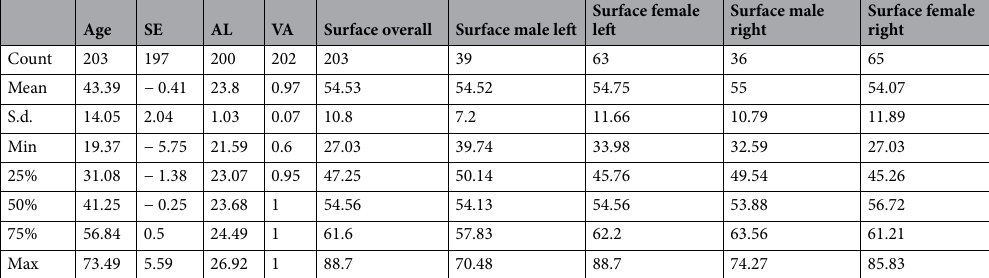
Table 1. Summary statistics of age, spherical equivalent (SE), axial length (AL), visual acuity (VA), and optical coherence tomography angiography (OCTA) retinal vessel surface area measurements. Summary statistics are calculated from 203 eyes (102 left and 101 right). Count indicates the number of eyes for which the respective measurements were available. Mean, s.d., min, 25%, 50%, 75%, and max indicate mean, standard deviation, minimum, 1st quartile, 2nd quartile, 3rd quartile, and maximum, respectively. Surface measurements are in mm 2